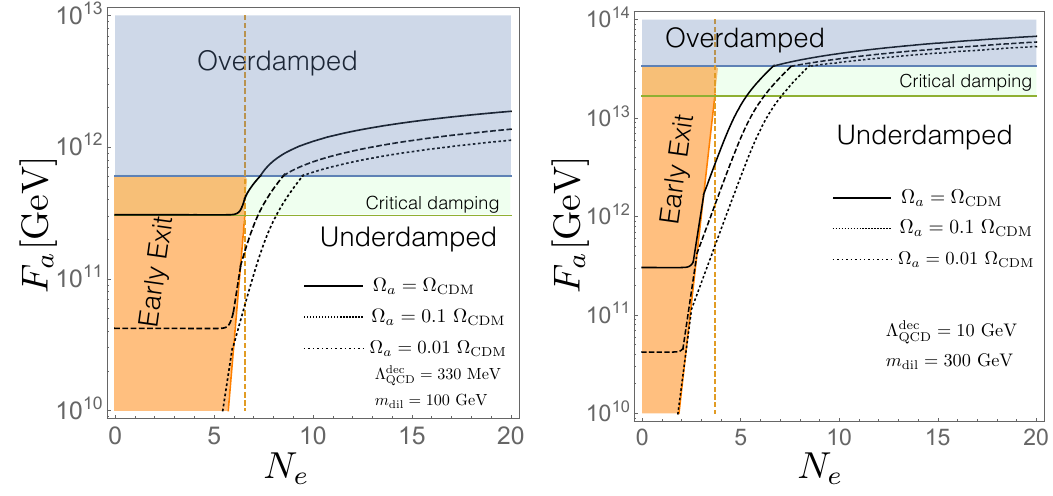
Figure 5 . Constraints on F a and N e from DM overproduction. We have taken (cid:3) dec = QCD 0 : 33 (10) GeV in the left (right) plot, as well as N = 5. In the blue region we have 3 H > 2 m a , in the green region 3 H 2 m a , and in the white region 3 H m a . In the orange region the supercooling (cid:20) (cid:20) era ends before the condition 3 H = m a is satis(cid:12)ed. Contours of (cid:10) a = 1 ; 0 : 1 ; 0 : 01 (cid:10) CDM are respec- tively shown as thick, dashed and dotted black lines respectively. The vertical orange dashed line shows the number of efolds corresponding to the critical QCD temperature during